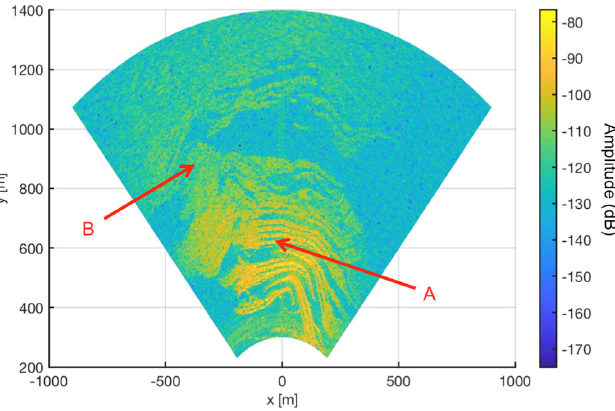
Figure 17. Radar image (without application of CS techniques) of a copper mine in South America.